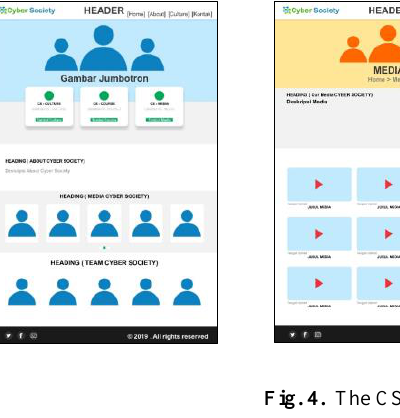
Fig. 4. The CS v.1.0